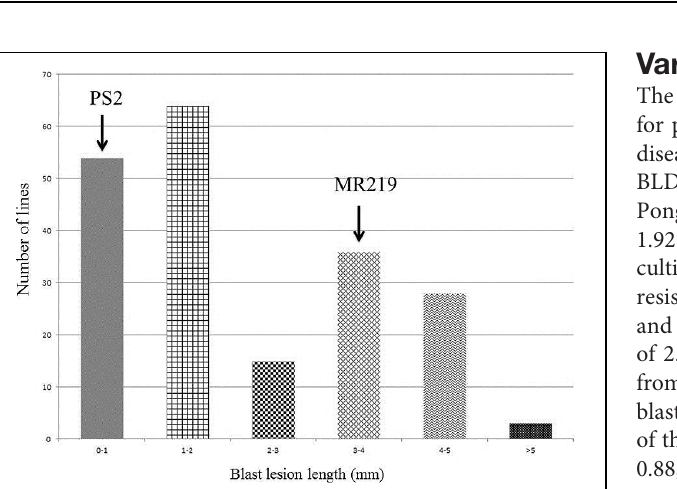
FIGURE 3 | Calculation of the distribution of blast lesion length after inoculation with Magnaporthe oryzae pathotype P7.2 in parental lines along with improved introgressed blast resistant gene lines of the BC 2 F 2 population ( n = 200).